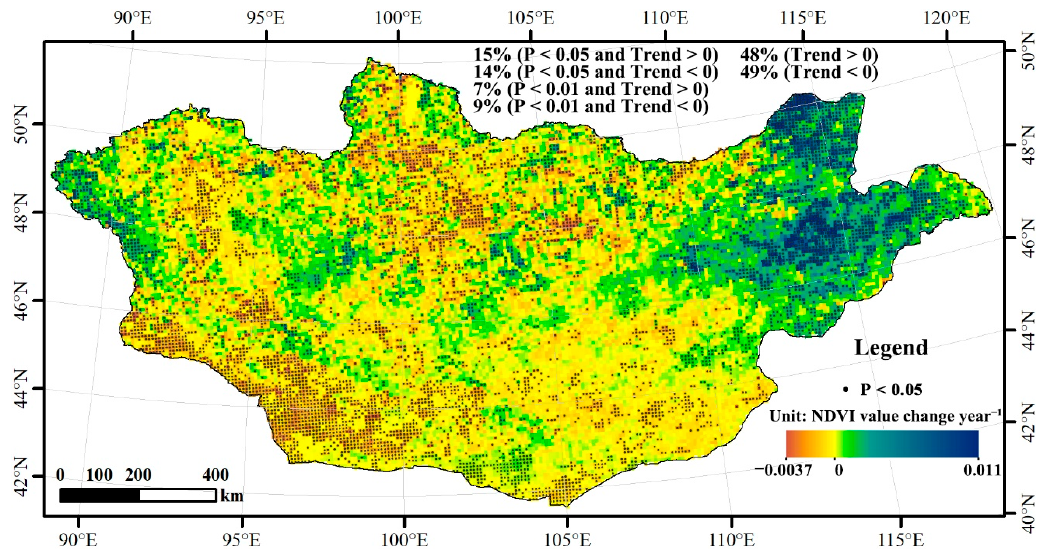
Figure 3. Trends of NDVI changes in Mongolia from 1982 to 2015. Regions labelled by black dots indicate that the trends were statistically significant (Mann–Kendall test; p < 0.05). The values at the top of figure are the pixel ratios.